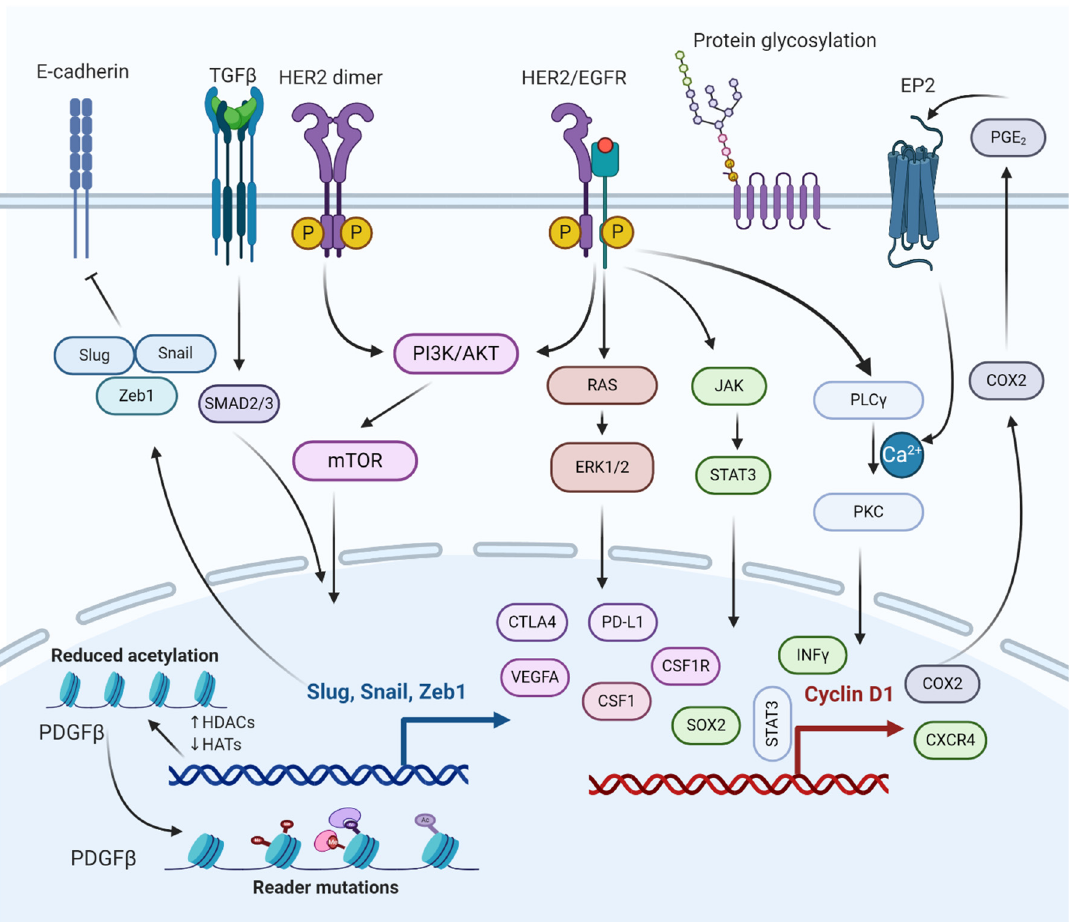
Figure 3. Molecular interactions of different pathways involved in the regulation of BCBM. The epithelial to mesenchymal transition (EMT) genes inhibit cadherin, promoting metastasis. PI3K/AKT/mTOR and RAS/RAF/ERK pathways activate cellular processes, such as cell proliferation, survival, migration, and angiogenesis. PI3K/AKT/mTOR and JAK/STAT pathways help BCBMs escape immunosurveillance. COX2 aids in prostaglandin synthesis and inflammation activation. Histone deacetylation of growth factors and protein glycosylation aid in bypassing the BBB.